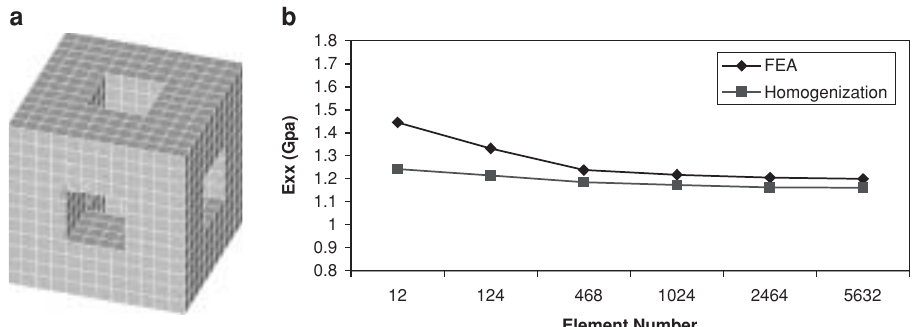
Figure 9 Effect of the number of elements on model predictions: (a) unit cell (scaffold) model and (b) model predictions.